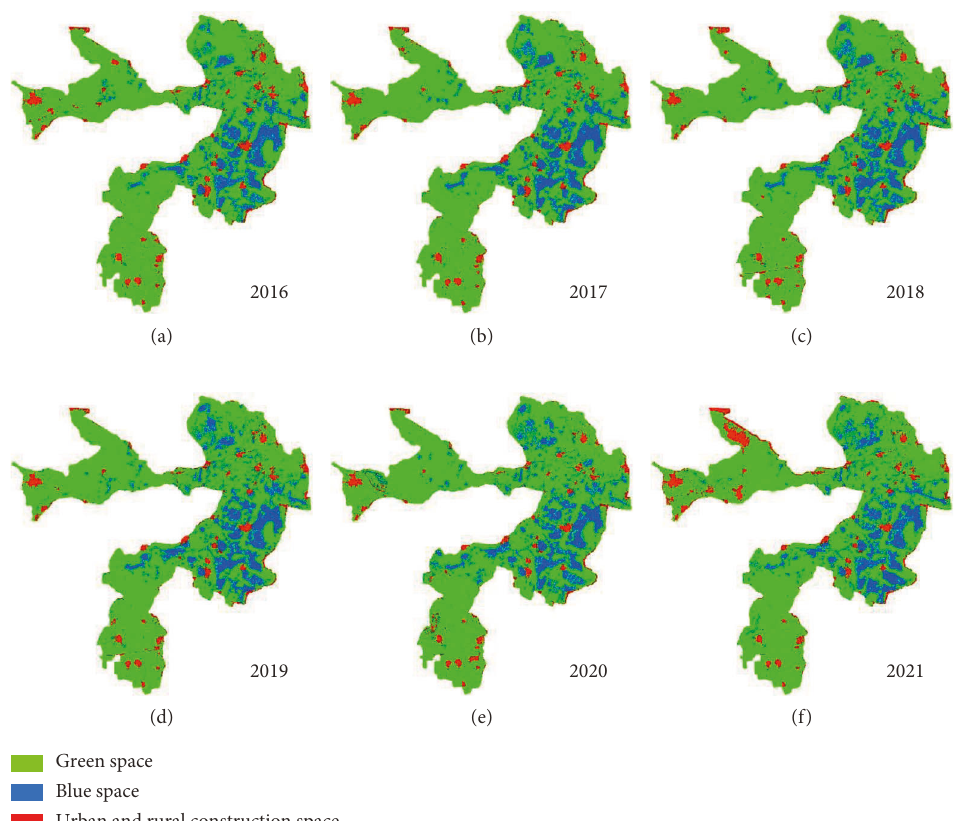
Figure 4: BGS distribution changes of Baiyangdian Wetland from 2016 to 2021. (a) 2016. (b) 2017. (c) 2018. (d) 2019. (e) 2020. (f) 2021.